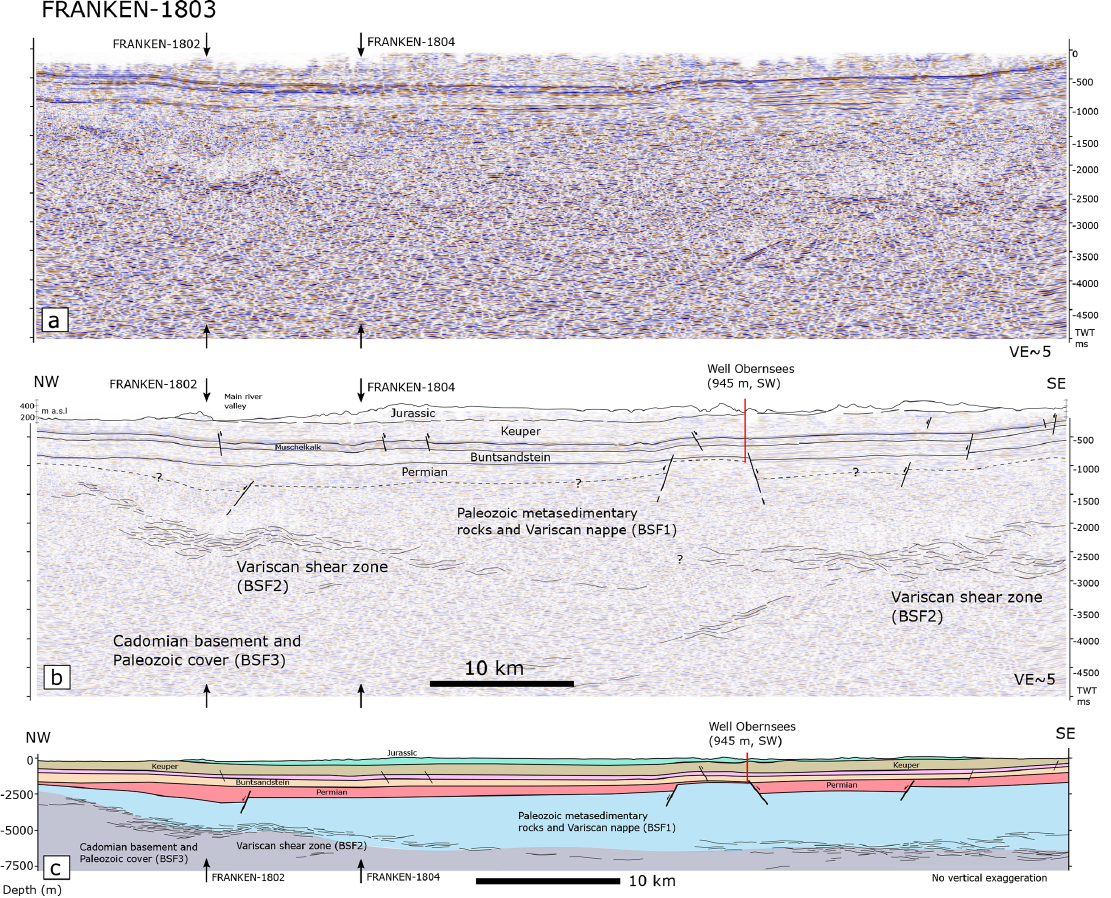
Figure 8. The SE–NW-striking FRANKEN-1803 profile, sub-parallel to the FRANKEN-1801 profile. Horizon interpretation is tied to the Obernsees well and the intersection of the FRANKEN 1801 and 1804 profiles. (a) Uninterpreted and (b) interpreted profile. (c) A depth- converted section with no vertical exaggeration. Interpreted Variscan shear zones (BSF2) are at 2000–3000ms (5–7km) in the SE and reach to ca. 2.5km depth toward the